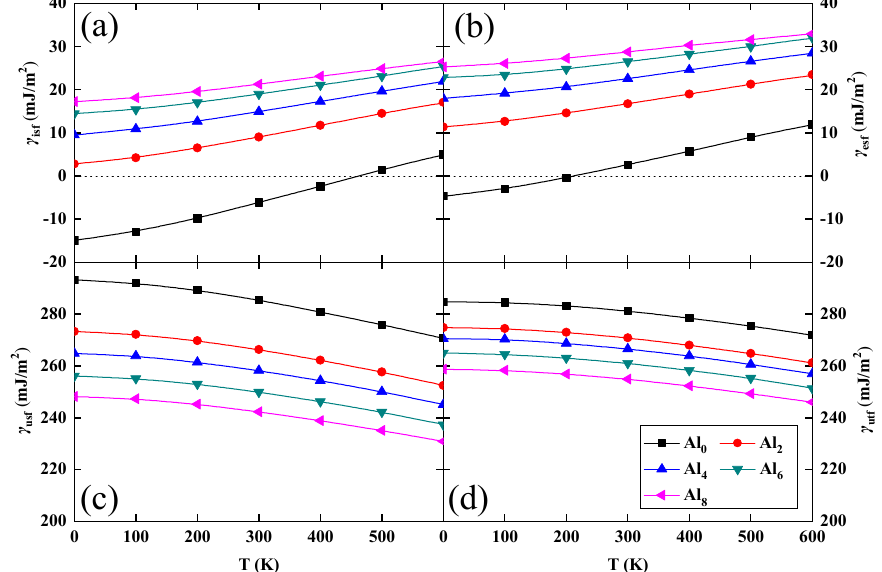
Figure 3. Theoretical generalized stacking fault energy ( γ , in mJ / m 2 ) of PM fcc Al y (CrMnFeCoNi) 100 − y ( y = 0, 2, 4, 6, 8) alloys as a function of temperature and composition. ( a ) The intrinsic stacking fault energy ( γ isf , in mJ / m 2 ); ( b ) The extrinsic stacking fault energy ( γ esf , in mJ / m 2 ); ( c ) The unstable stacking fault energy ( γ usf , in mJ / m 2 ); ( d ) The unstable twinning fault energy ( γ utf , in mJ / m 2 ).